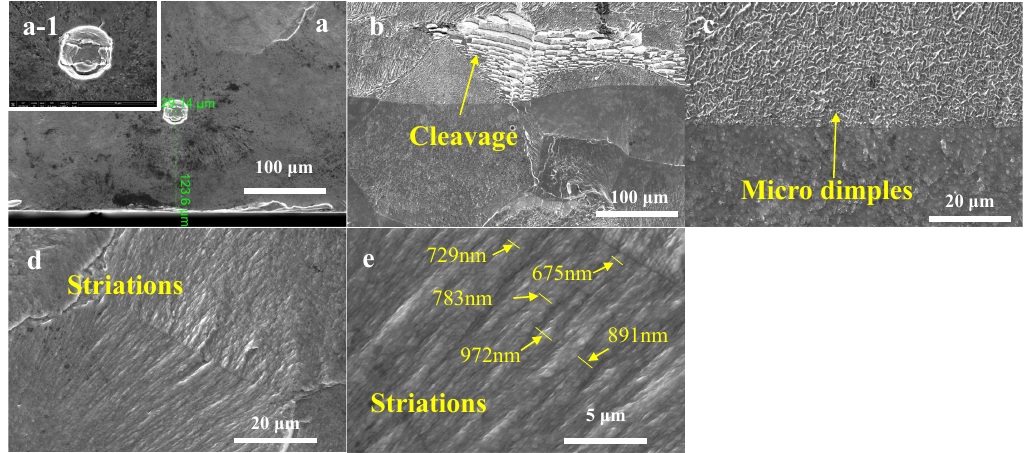
Figure 12. The facture morphologies of LMD+LSPned samples: ( a ) crack initial place; ( b ) cleavage facets; ( c ) microdimples; ( d , e ) fatigue striations.